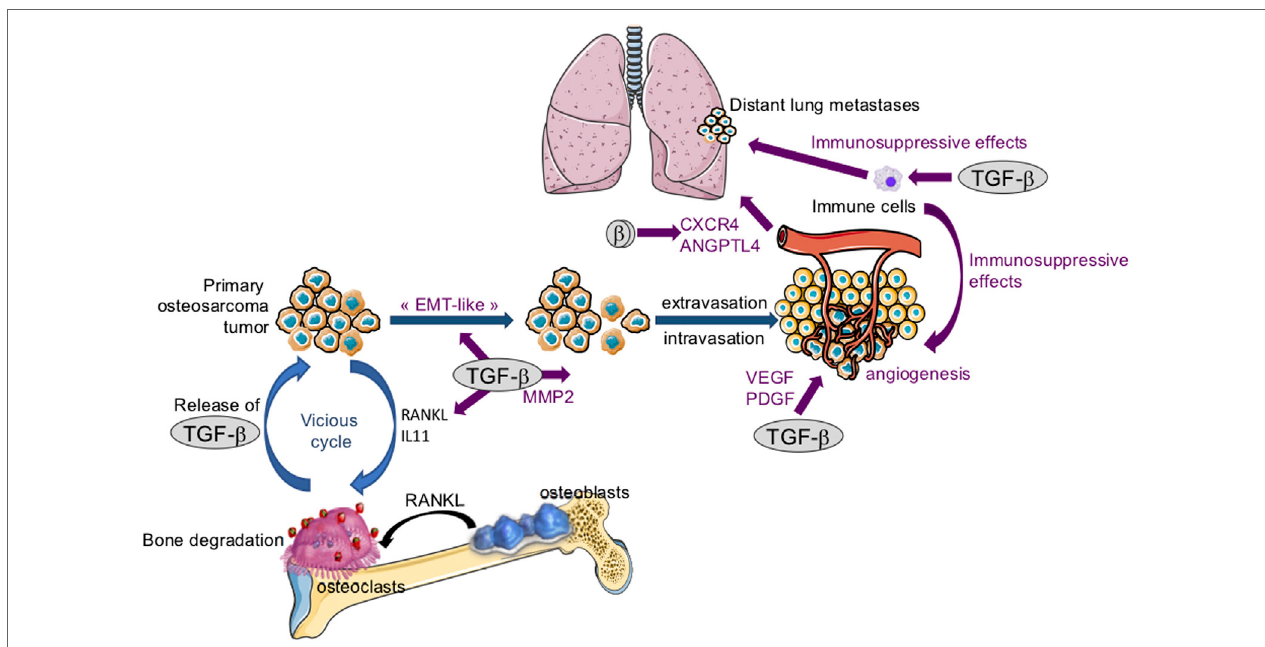
FiGURe 4 | The crucial role of transforming growth factor- β s (TGF- β s) in osteosarcoma tumor growth and metastatic dissemination. Following bone degradation, the TGF- β s trapped in the bone matrix are released and promote osteosarcoma growth and metastatic dissemination by targeting both osteosarcoma tumor cells and their microenvironment. TGF- β s target osteosarcoma cells : TGF- β s stimulate “epithelial–mesenchymal transition-like” (EMT), cell migration, and invasion in part by increasing matrix metalloproteinase-2 (MMP-2) expression. TGF- β s target tumor microenvironment : TGF- β s upregulate the expression of osteolytic factors such as receptor activator of nuclear factor kappa-B ligand (RANKL) and interleukin-11 (IL-11) and therefore stimulate bone osteolysis and the secretion of protumoral factors. TGF- β s upregulate platelet-derived growth factor (PDGF) and vascular endothelial growth factor (VEGF) expression, and therefore angiogenesis. Finally, TGF- β s exert immunosuppressive effects by regulating immune cell proliferation and